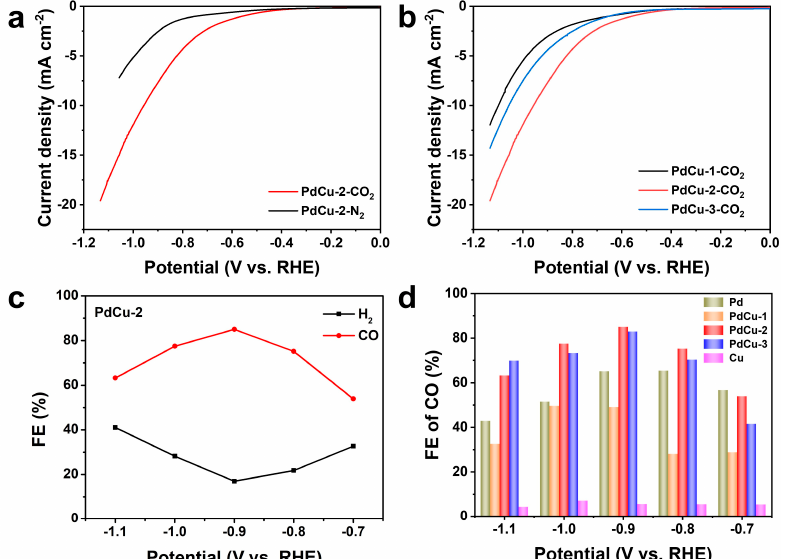
Figure 3. LSV curves and FE of the catalysts: ( a ) LSV curves of PdCu − 2 in CO 2 (red line) and N 2 -saturated (black line) 0.5 M KHCO 3 solution; ( b ) LSV curves of PdCu − 1 (black line), PdCu − 2 (red line), and PdCu − 3 (blue line) in CO 2 -saturated 0.5 M KHCO 3 solution; ( c ) FE of CO and H 2 on PdCu − 2 at the applied potentials; ( d ) FE of CO on Pd, PdCu − 1, PdCu − 2, PdCu − 3, and Cu at the applied potentials.